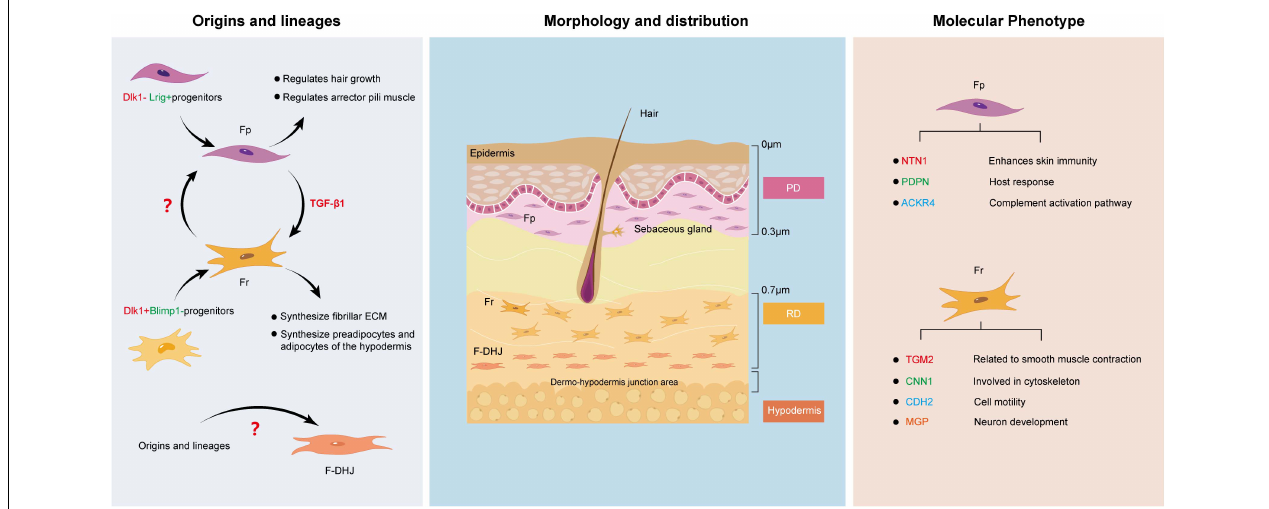
FIGURE 1 | Similarities and differences between Fps, Frs, and F-DHJs: Origins and lineages, morphology and distribution, and molecular phenotype.